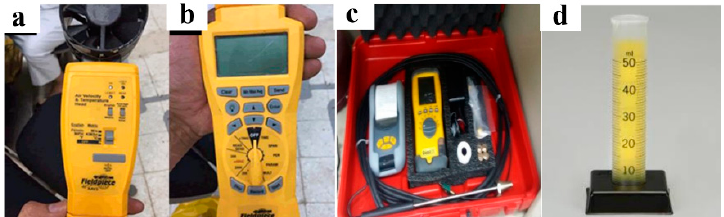
Figure 7. ( a ) Fieldpiece AAV3 air mass flow sensor; ( b ) DL2 data logger, ( c ) Exhaust Gas Analyzer (Eagle x155), ( d ) graduated cylinder.